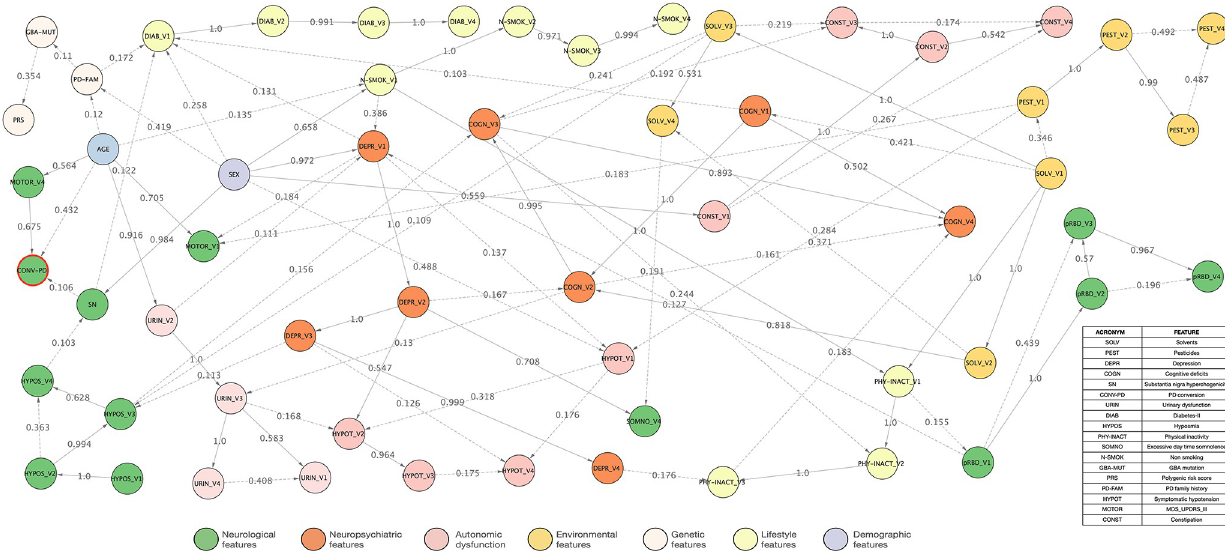
Fig 1. Interdependencies between different risk markers and prodromal markers of Parkinson’s Disease. The depicted Bayesian network represents interdependencies between variables learned from prospective TREND data. Domains of marker nodes are indicated by circle color. The node of the “Conversion to PD” is indicated by a red circle outline. Numbers on edges indicate the level of statistical confidence (bootstrap probability), and dashed edge lines indicate confidences < 0.5 while solid lines indicate a confidence � 0.5. A higher value indicates a higher confidence in the existence of a connection. Nodes isolated from the rest of the network are not shown. V indicates the respective visit